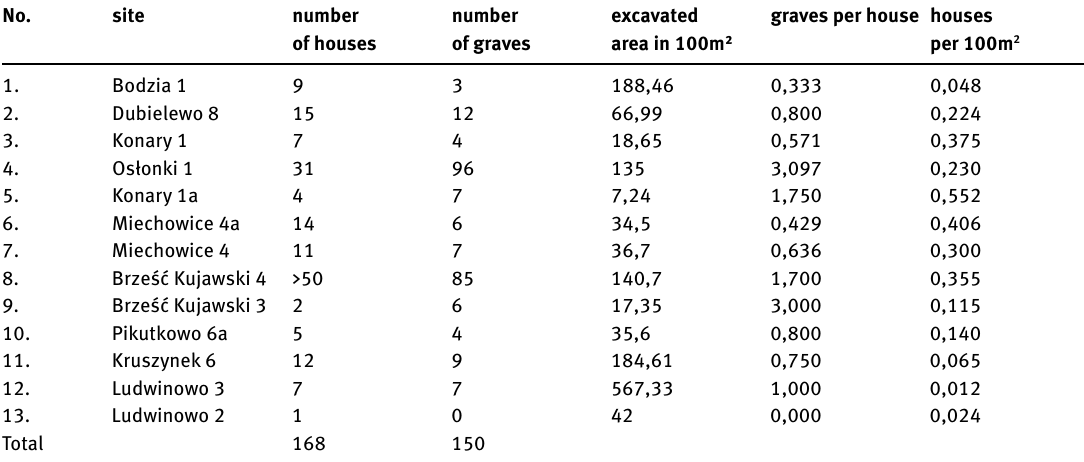
Table 1 . Characterisation of BKK settlements from the Brześć Kujawski region. Numbers of sites according to Figure 2.